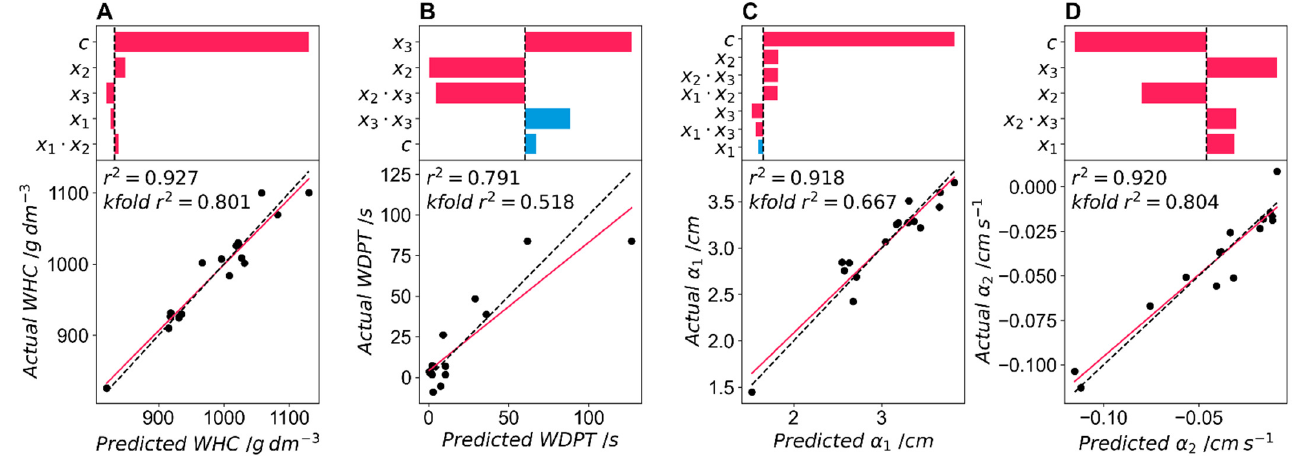
Figure 10. Model fitting figures for the foam hydrodynamic property responses. The t-ratio for each of the model coefficients is shown in the top half of each subplot, with the pink bars indicating an absolute value t-ratio of greater than 2 (and a p < 0.05) and blue bars indicating an absolute value t-ratio below 2 (and a p > 0.05). The vertical dotted line indicates the zero axis. The bottom chart shows the predicted and actual foam properties, with the solid line indicating the fit and the dashed line showing the y = x line. Figures are displayed for ( A ) water holding content, ( B ) water drop penetration time ( C ) maximum capillary rise and ( D ) the rate of water uptake.